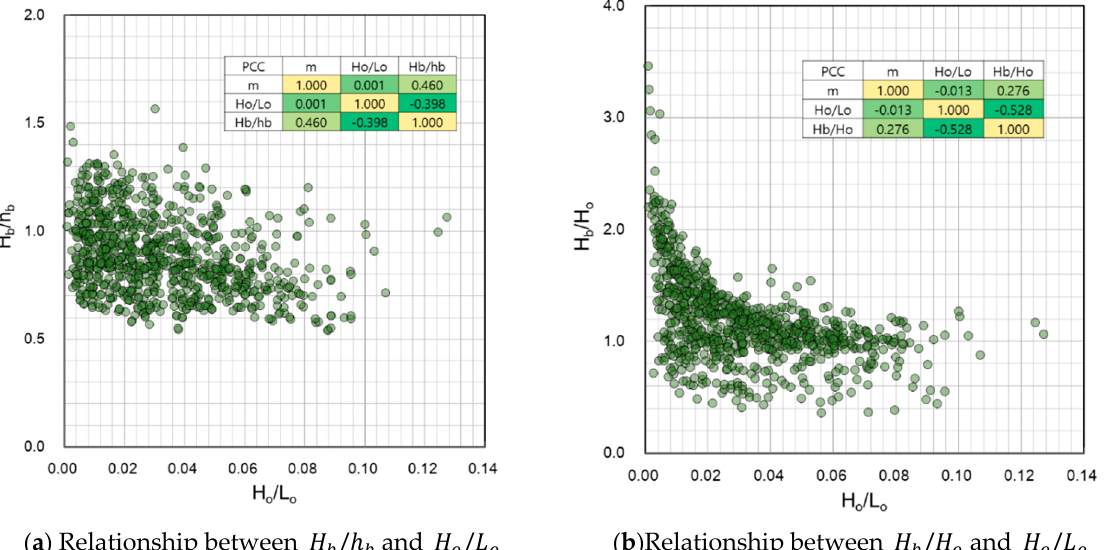
Figure 2. Relationship between breaker indices: ( a ) H b / h b , ( b ) H b / H o and deep-water wave steepness H o / L o by historical laboratory experiments.